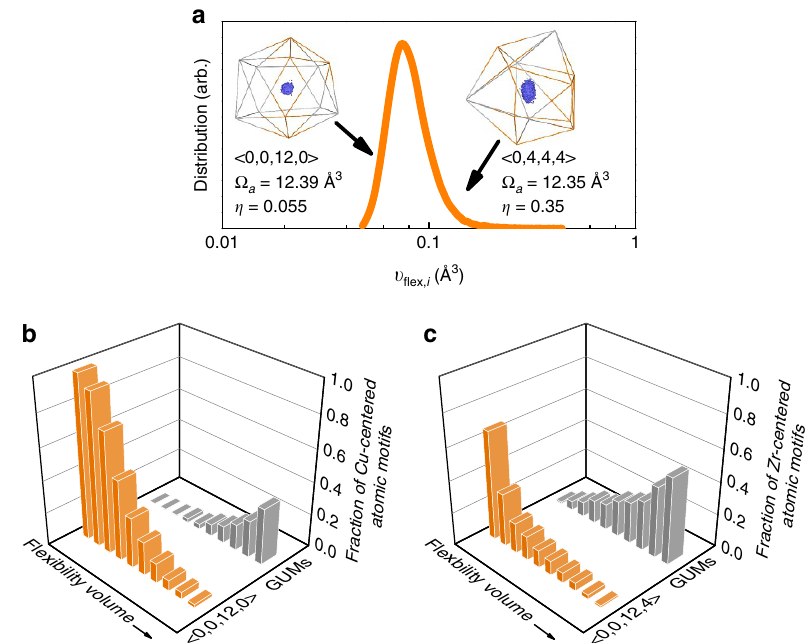
Figure 3 | Flexibility volume correlates strongly with local atomic packing structure. ( a ) Distribution of flexibility volume ( u flex, i ) in a Cu 64 Zr 36 MG (Sample G28). The insets show two Cu atoms in this distribution. These two atoms (each at the centre of a Voronoi polyhedron as indexed above) have almost the same atomic volume (Voronoi volume), but the more anisotropic case (higher Z ) has a value for u flex, i twice as large as that in the more regular full icosahedron. The bi-coloured lines connect nearest neighbours (grey for Zr and gold for Cu). The central blue region represents the maximum volume sampled during the simulation by the centre of mass of the vibrating Cu atom. In ( b ) (or ( c )), Cu (or Zr) atoms in this Cu-Zr MG are first sorted by their flexibility volume (from low to high), and then divided into ten groups each containing 10% of all Cu (or Zr) atoms. The fraction of Cu-centred o 0, 0, 12, 0 4 (or Zr-centred o 0, 0, 12, 4 4 ) and GUM clusters present in these ten groups is then compared. For the 10% of the atoms with the lowest flexibility volume, almost all of the Cu atoms are in o 0, 0, 12, 0 4 (and Zr in o 0, 0, 12, 4 4 ) clusters, whereas most of the 10% atoms with the highest flexibility volume are in